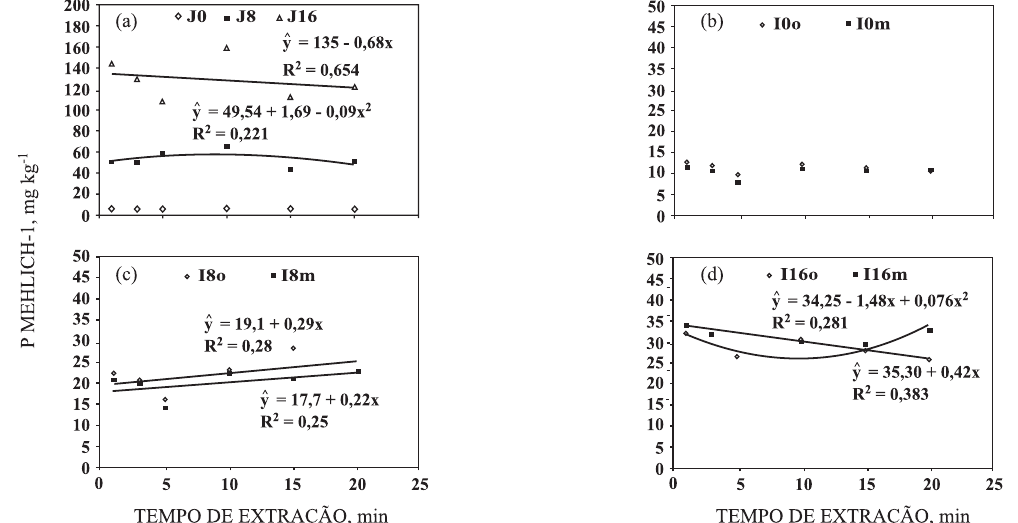
Figura 2. Extração pelo método Mehlich-1 nos solos de Jaguariúna (a) e Itatinga (b, c e d), em função do tempo de extração e da dose de lodo aplicada ao